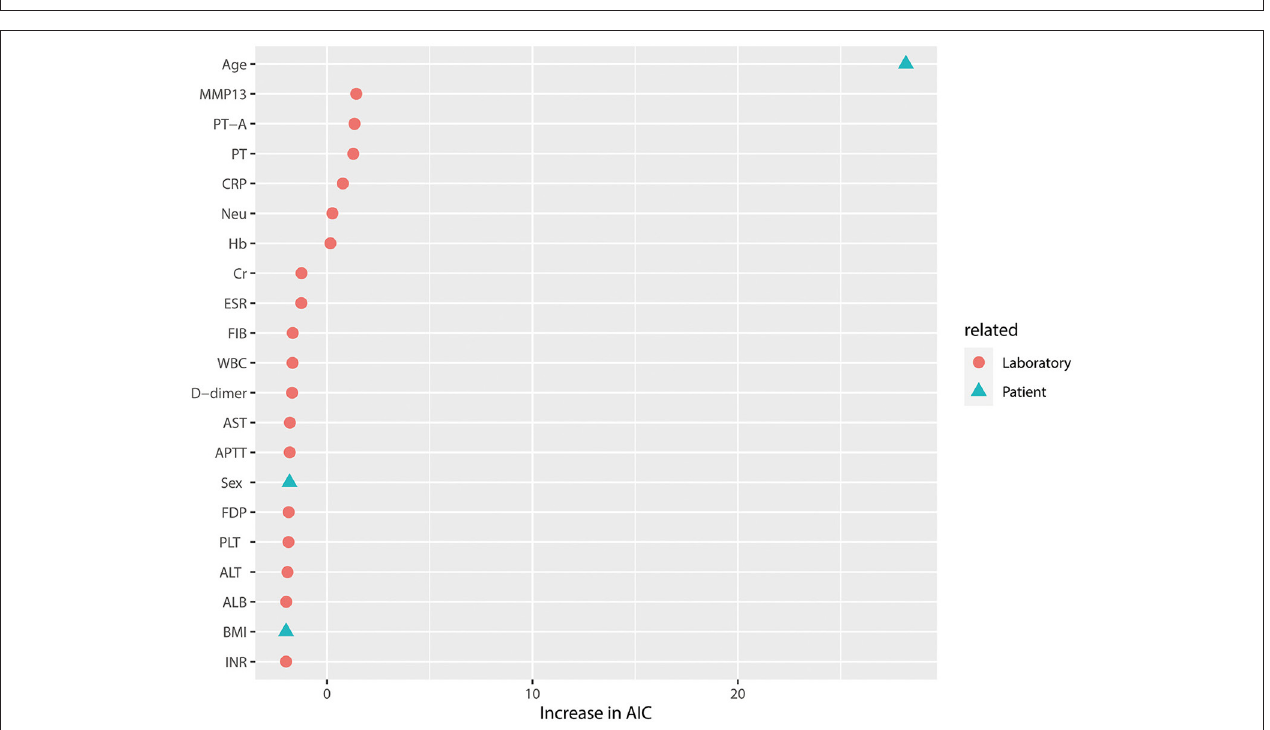
FIGURE 4 | Relative variable importance of each predictor in the full model of OA grouped by risk factors related to laboratory and patient. The factors for knee OA were involved in the full model. Patient age was the major risk factor for knee OA in the full model. Despite the AIC value of < 2, MMP-13 was also a major risk factor for knee OA compared with other laboratory-related factors. ESR, erythrocyte sedimentation rate; PT-A, plasma thromboplastin antecedent; PT, prothrombin time; CRP, C-reactive protein; Neu%, neutrophil ratio; Hb, hemoglobin; Cr, creatinine; ESR, erythrocyte sedimentation rate; FIB, fibrinogen; WBC, white blood cell count; AST, aspartate aminotransferase; APTT, activated partial thromboplastin time; FDP, fibrin degradation product; PLT, platelet count; ALT, alanine aminotransferase; ALB, albumin level; INR, international normalized ratios; BMI, body mass index.